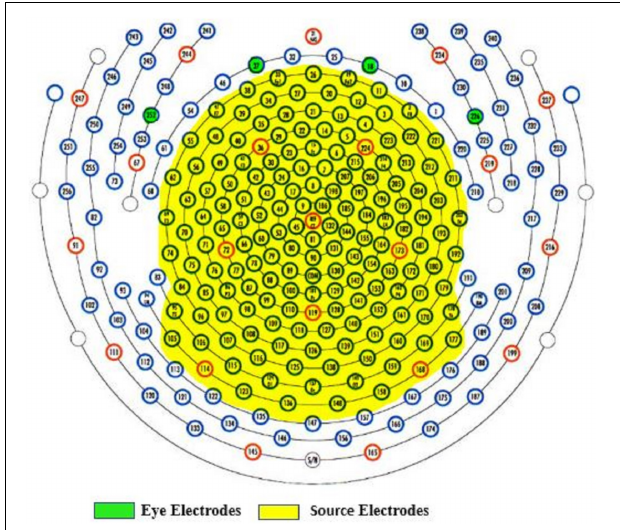
FIGURE 3 | Yellow highlighted areas indicate selected electrodes for source estimation. Data from electrodes near or on the cheeks or close to the nape of the neck were removed to reduce noise. Vertical (E18, E37) and lateral (E252, E226) eye electrodes are highlighted in green.